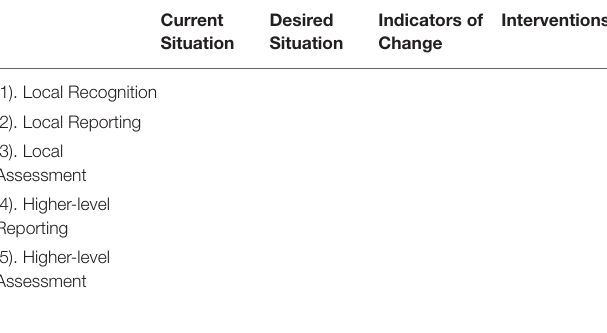
TABLE 2 | Modified theory of change approach and